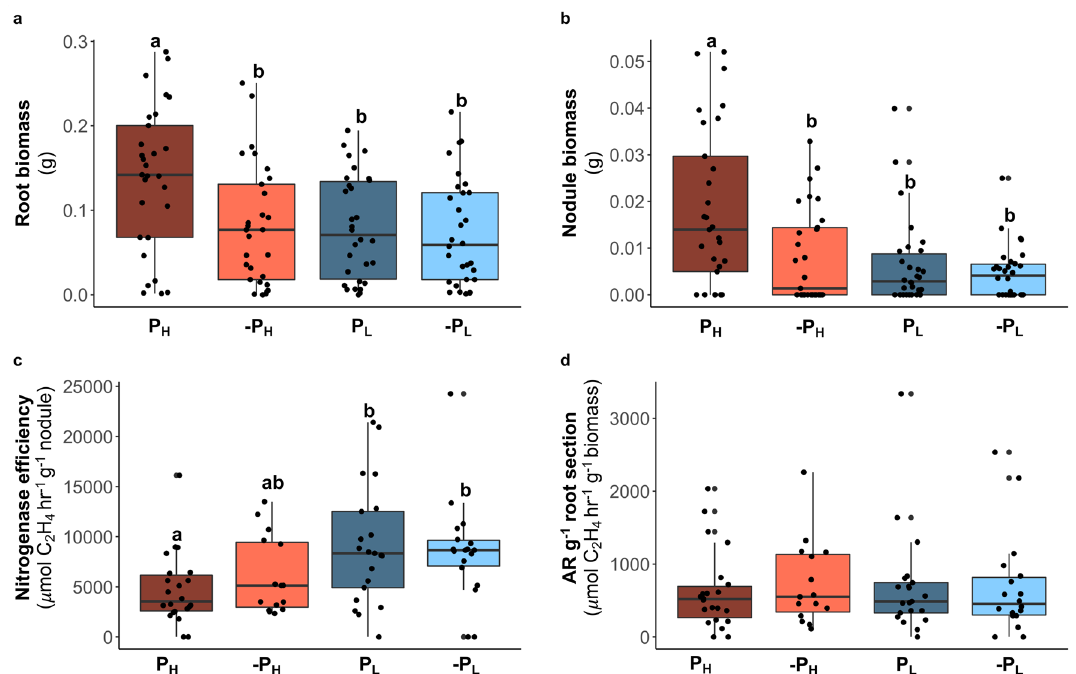
groups. Boxes represent the interquartile range, the line is the median, and the whiskers are the lowest or highest value within 1.5 times the interquartile range. Points represent the values from individual root sections within each treatment. Points were jittered within treatment to prevent